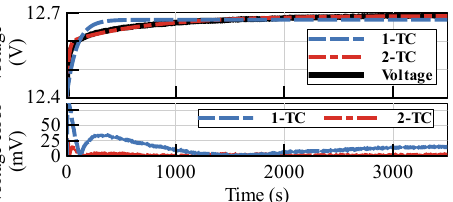
Figure 5. Performance comparison of one and two RC time